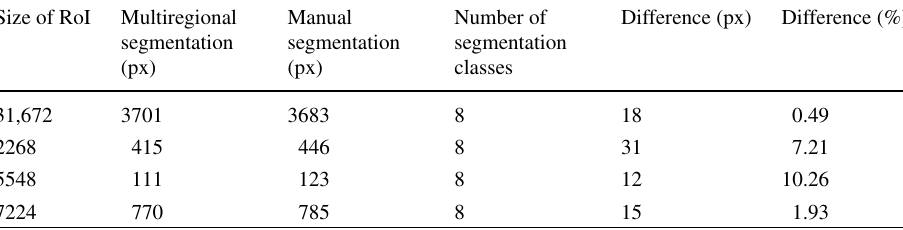
Table 2 Results of verification of multilevel blood vessel